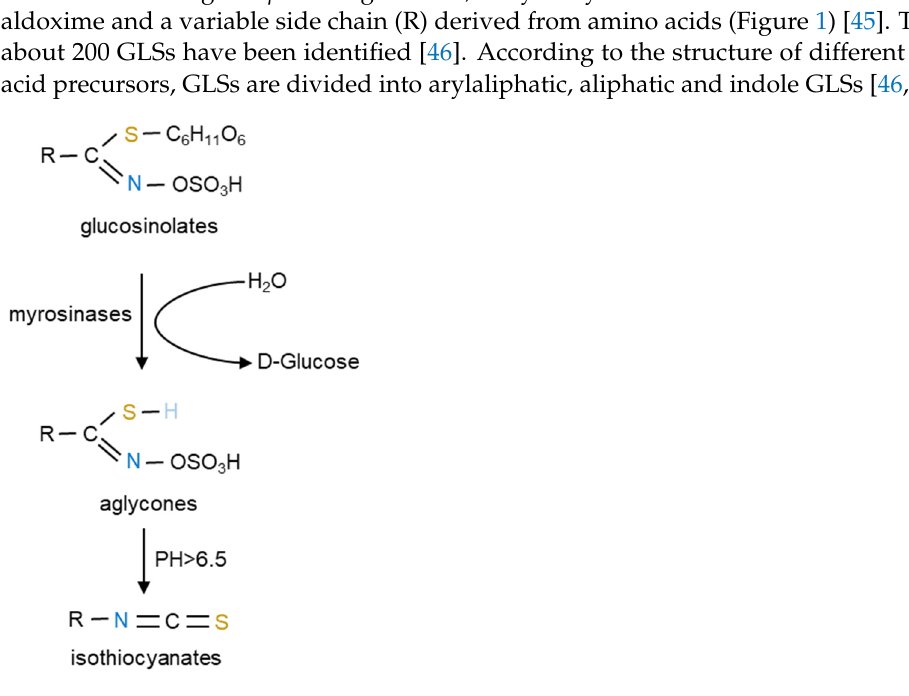
Figure 1. Glucosinolate hydrolysis into isothiocyanates by myrosinases. Glucosinolates (GLSs) are determined by a β -D-thioglucoside, N-hydroysulfates sulfur-linked to a sulfonate aldoxime and a variable side chain (R) derived from amino acids. GLSs generate aglycones under the action of myrosinases. As the structure of aglycones is unstable, ITCs are generated when the pH is greater than 6.5. Nitrogen, sulfur and hydrogen are indicated in blue, yellow and light blue, respectively.